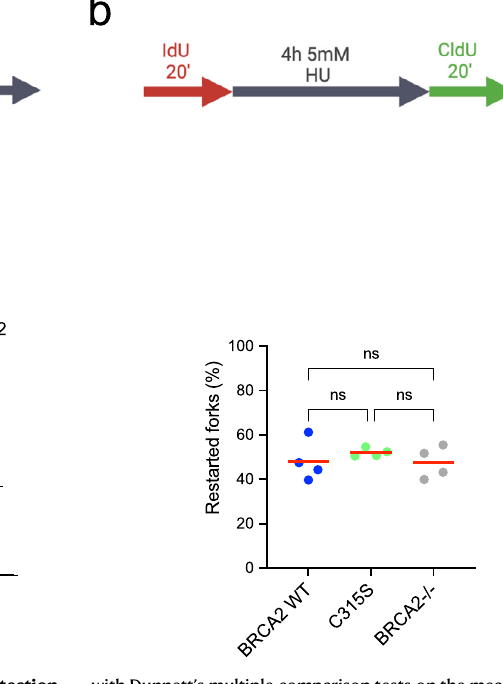
with Dunnett ’ s multiple comparison tests on the mean of each experiment. ns, not signi fi cant, * p <0.05 ( p =0.0414). b Schematic of the single-molecule DNA fi ber tractanalysisto detectfork restart afterHUtreatment.Quanti fi cation ofrestarting forks in BRCA2-de fi cient DLD1 cells, BRCA2 WT cells, or cells bearing the BRCA2 C315S variant, as indicated. Data are from four independent experiments; the percentagewascalculatedexpressingthepresenceofCldUadjacenttoIdUandwas established on 200 – 500 tracks scored for each data set. The horizontal red line represents the mean. Statistics: Kruskal – Wallis test followed by Dunn ’ s multiple comparison test. (ns, not signi fi cant). Labeling schemes created with BioR- ender.com. Source data are provided as a Source Data fi